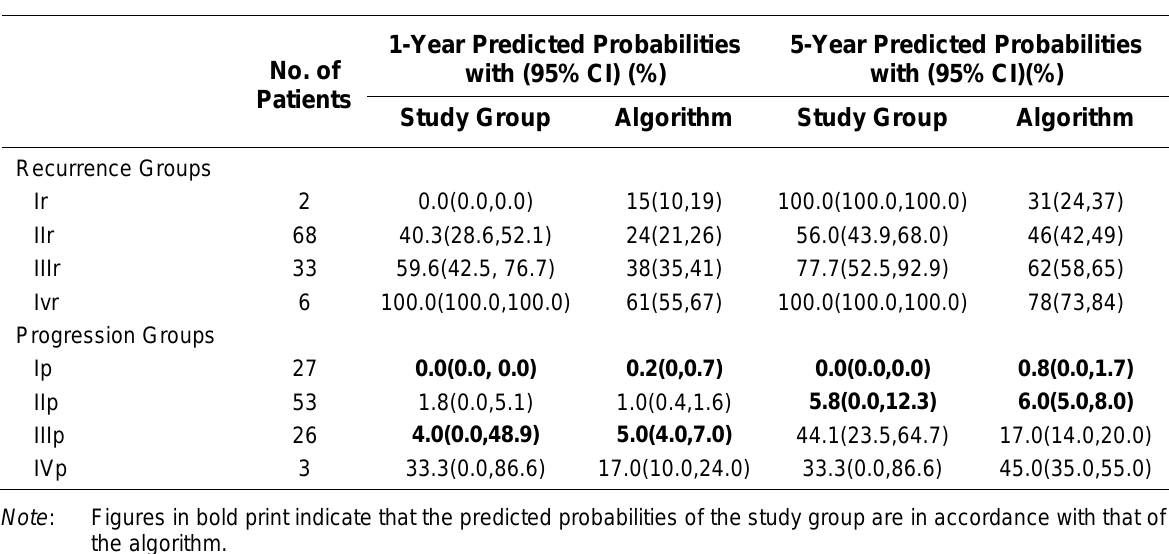
Comparing the Predicted Probabilities of Recurrence and Progression of Our Study Group